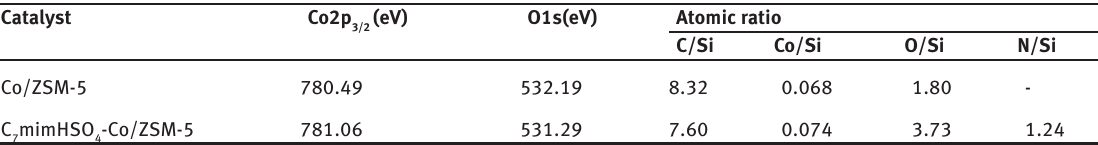
Table 2: XPS analysis of catalysts. Catalyst Co2p